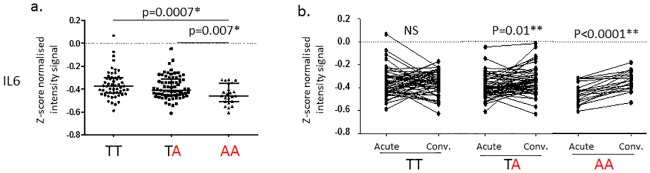
Transcript levels for IL6 in whole blood samples from KD subjects as a function of genotype for rs56245262 in TLR6.TLR6 rs56245262 risk allele (A) is shown in red. Transcriptome data from a. Acute, pre-treatment (n = 146: T/T n = 54, T/A n = 69, A/A n = 23), b. Paired acute, pre-treatment and convalescent (n = 131: T/T n = 53, T/A n = 58, A/A n = 20). P-values were calculated using Mann Whitney test for (a) and Wilcoxon matched-paired test for (b).